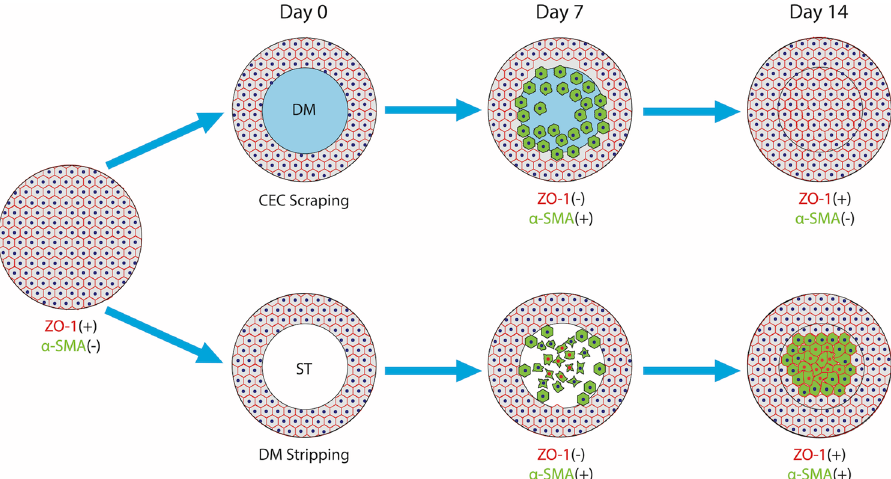
Figure 10. Schematic drawing on the hypothesis of corneal endothelial would healing process after CEC scraping or DM stripping injury. After CEC scraping injury, central corneal endothelial cells were removed and the underneath Descemet’s membrane (DM) was exposed at day 0. Seven days after the injury, CECs in the peripheral cornea migrated into the wounding area. These cells exhibited endothelial mesenchymal transition. At day 14, the wounding area was resurfaced by the migrating cells, and these cells regained endothelial phenotype through mesenchymal endothelial transition. After DM stripping injury, central corneal endothelial cells were also removed and the central corneal stroma (ST) was exposed at day 0. Seven days after the injury, few CECs in the peripheral cornea migrated into the wounding area. On the other hand, some keratocytes were activated and changed into myofibroblastic phenotype (red nuclei cells). At day 14, the wounding area was resurfaced by two types of cells, one from migrated endothelial cells, while the other from keratocytes. These cells partially regained endothelial cell